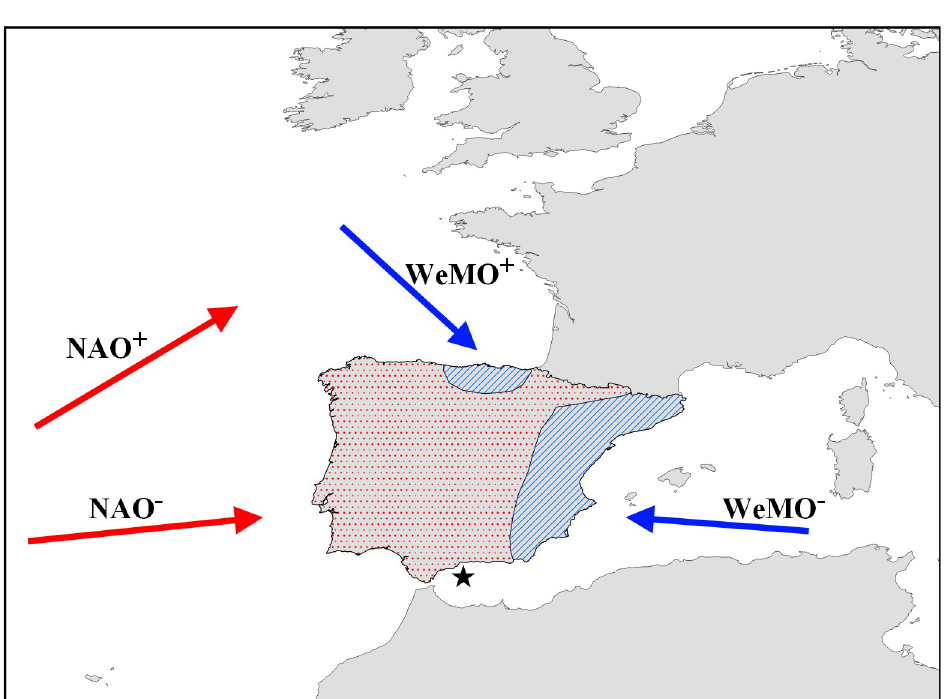
Fig 2. Main atmospheric drivers of temporal precipitation variability on the Iberian Peninsula. Map showing areas on the Iberian Peninsula, where temporal winter (October–March) precipitation variability is dominated by the NAO (dotted red) and the WeMO (hatched blue). Areas have been redrawn from [45] . Red arrows indicate dominant wind direction under NAO + and NAO - conditions, respectively. Blue arrows indicate the same for WeMO + and WeMO - conditions. Star indicates the location of marine sediment core